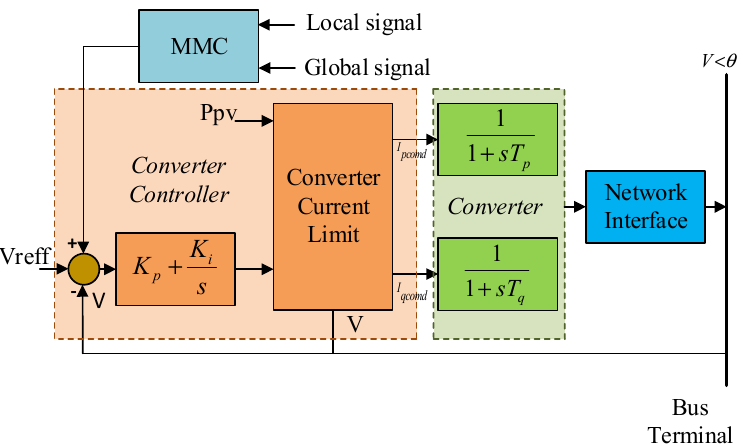
Figure 1. PV plant with multimodal controller.